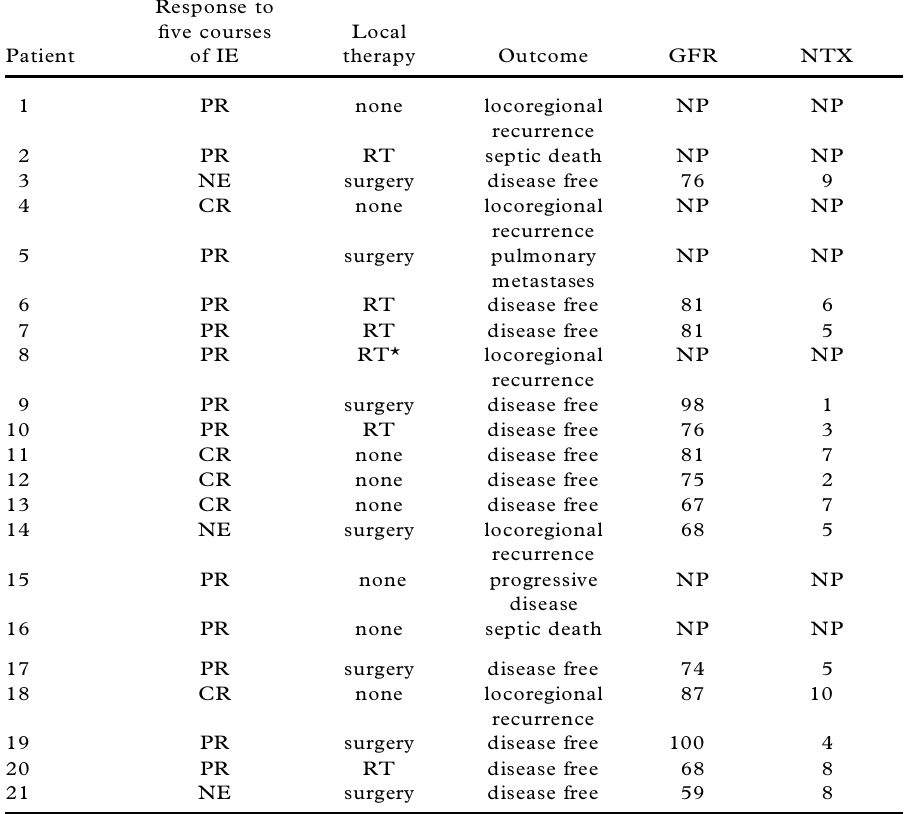
Table 2. Treatment